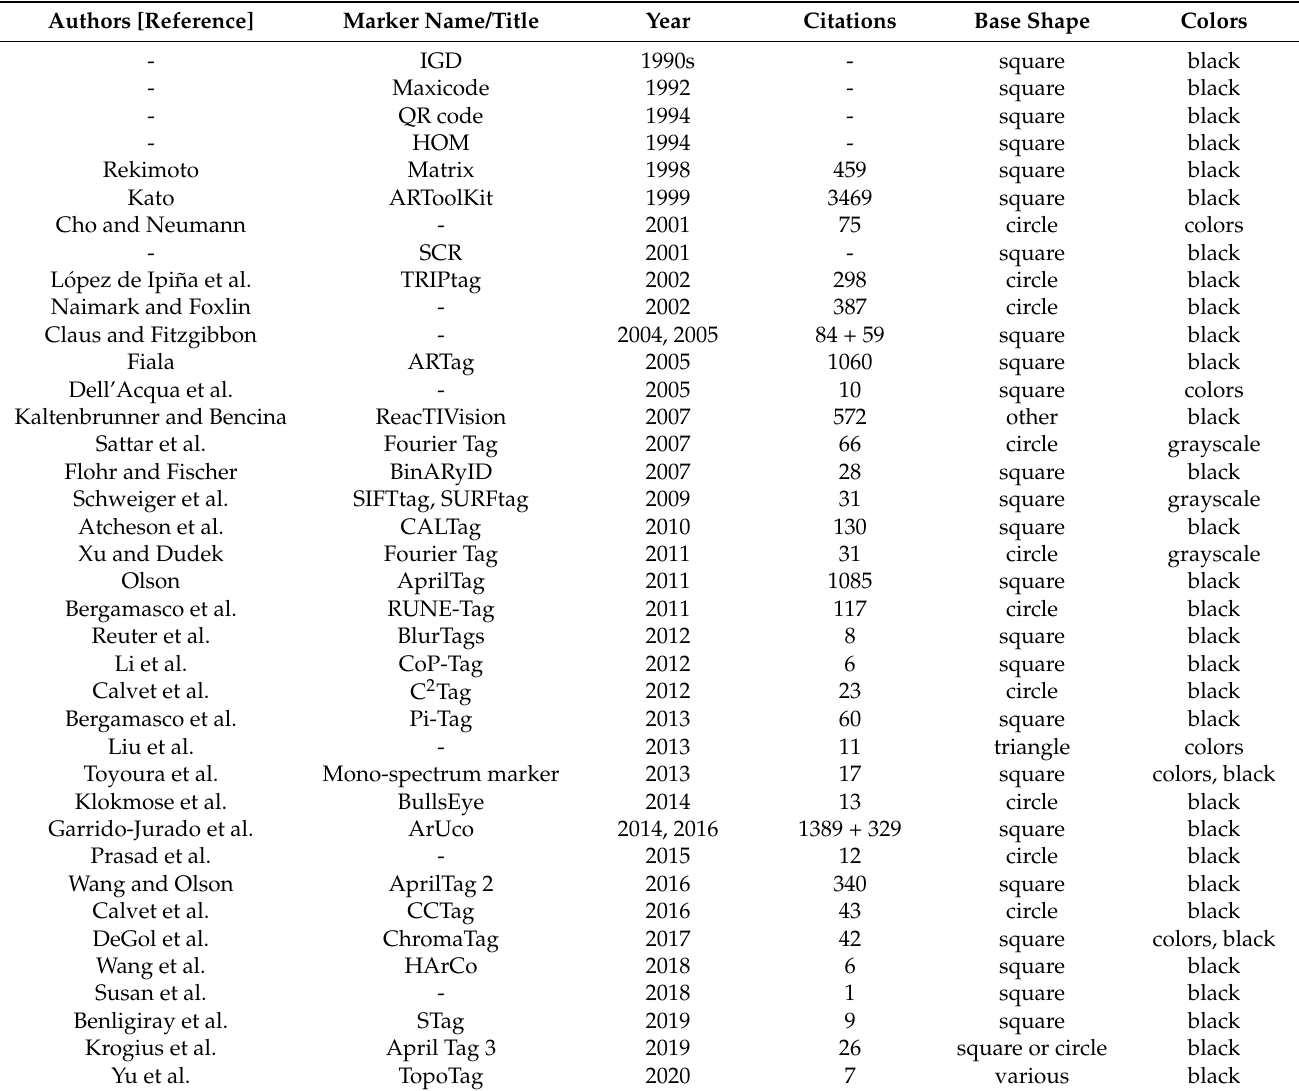
Table 1. Chronological summary of the investigated marker